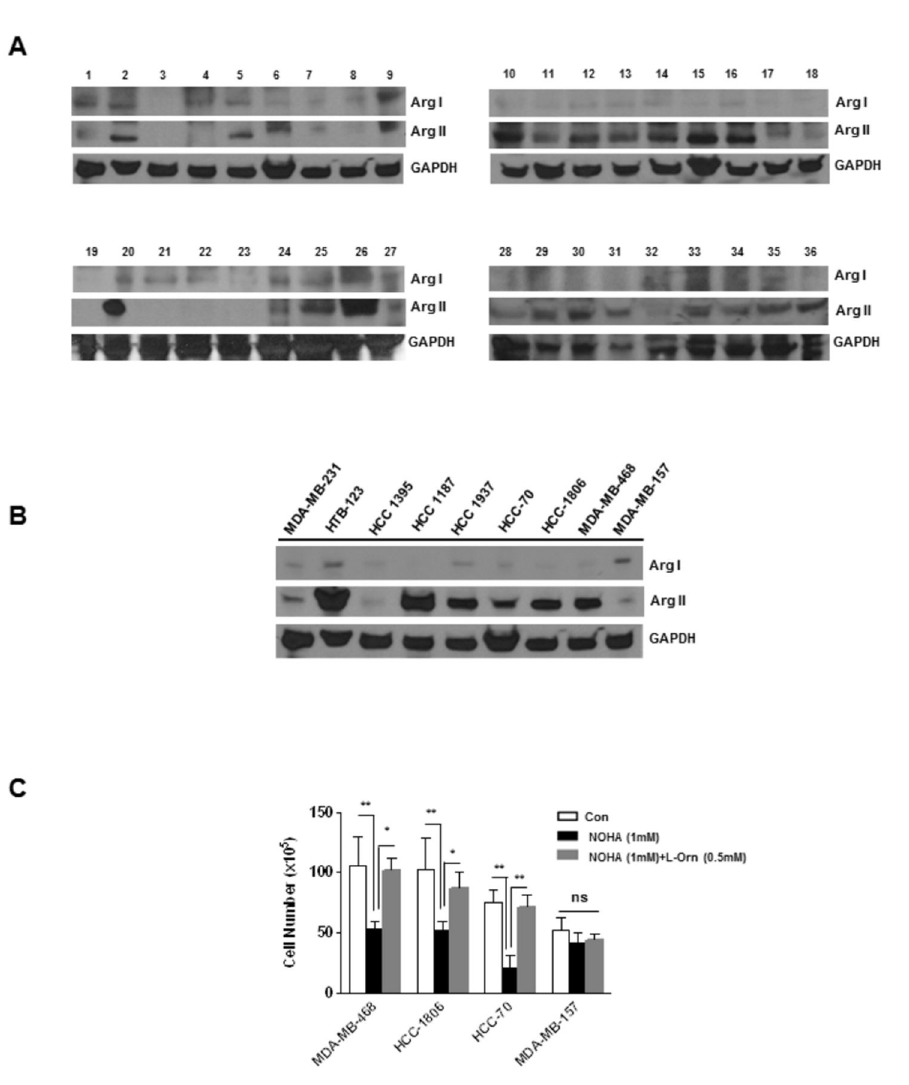
Figure 1. Analysis of Arg I and Arg II in human breast tumor specimen and established breast cancer cells. A , 50 µg of breast tumor lysates (1-36) obtained from CHTN and NDRI were analyzed by Western blot analysis using anti-Arg I or anti-Arg II antibodies. B , 50 µg of cell lysates obtained from established breast cancer cells were analyzed by Western blot analysis using anti- Arg I or anti-Arg II antibodies. C , Selective Inhibition of cell proliferation by NOHA (1mM) in high Arg II expressing breast cancer MDA-MB-468, HCC1806, HCC 70 and MDA-MB-157 cells and blockade of this effect by exogenous L-ornithine (L-Orn) (500µM). *, p≤0.05;